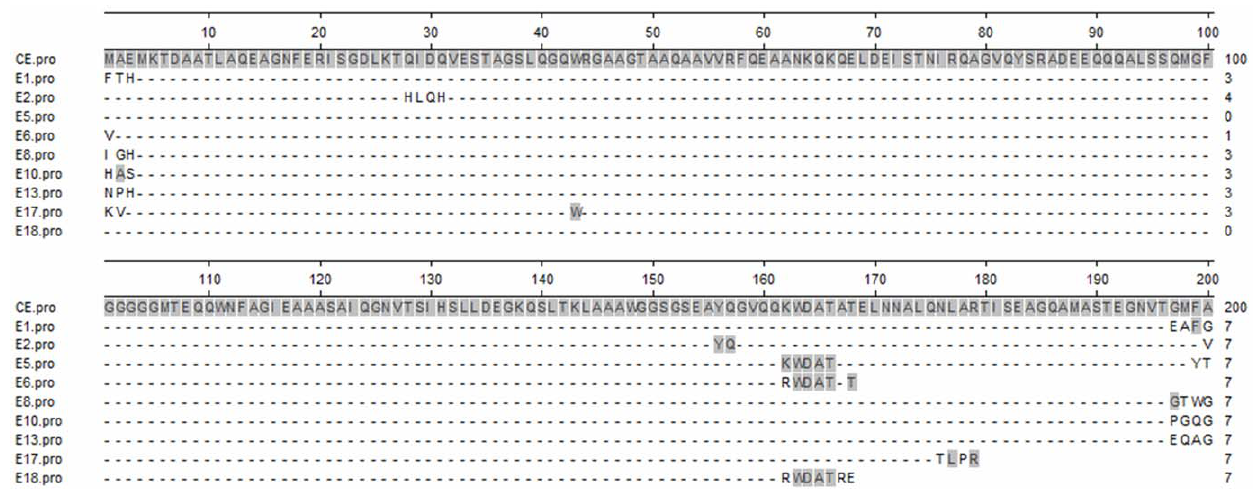
Figure 1. Alignment of selected phage clones to the CE amino acid sequence. Individual phage clone peptide sequence was aligned to the CE sequence (1–200 amino acids) using an alignment software (DNASTAR). Consensus amino acid sequences between individual phage clone peptide sequences and CE sequence are highlighted with solid light gray shade.